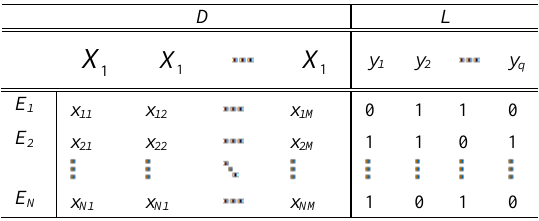
Figure 1.Multi-label